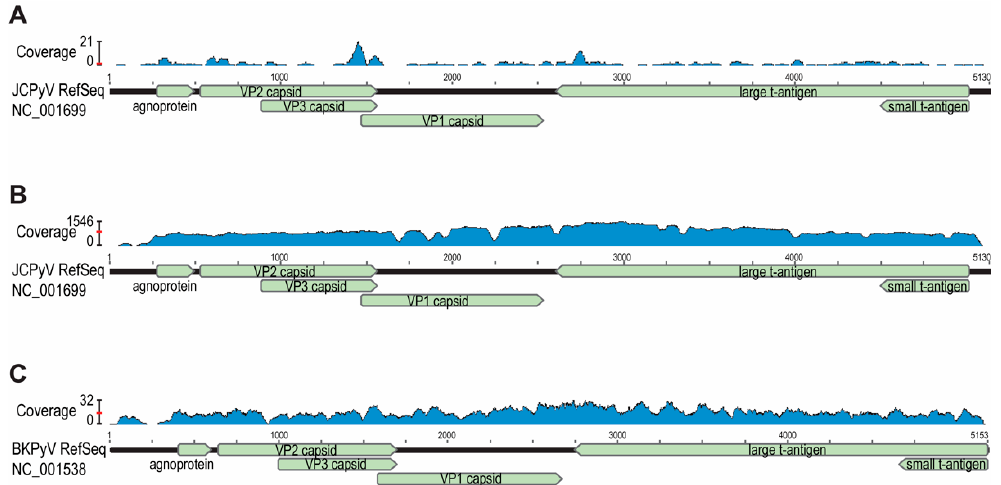
Figure 1. Raw read coverage of JCPyV and BKPyV reference genomes. ( A ) Coverage of the JCPyV genome for sample ERR2798128 reads; average coverage (indicated by red bar) was ~1 reads/nucleotide and was concentrated on sequences conserved between JCPyV and BKPyV. ( B ) Coverage of the JCPyV genome for sample ERR2798125 reads; average coverage (indicated by red bar) ~900 reads/nucleotide. ( C ) Coverage of the BKPyV genome for sample ERR2798128 reads; average coverage (indicated by red bar) was ~15 reads/nucleotide.